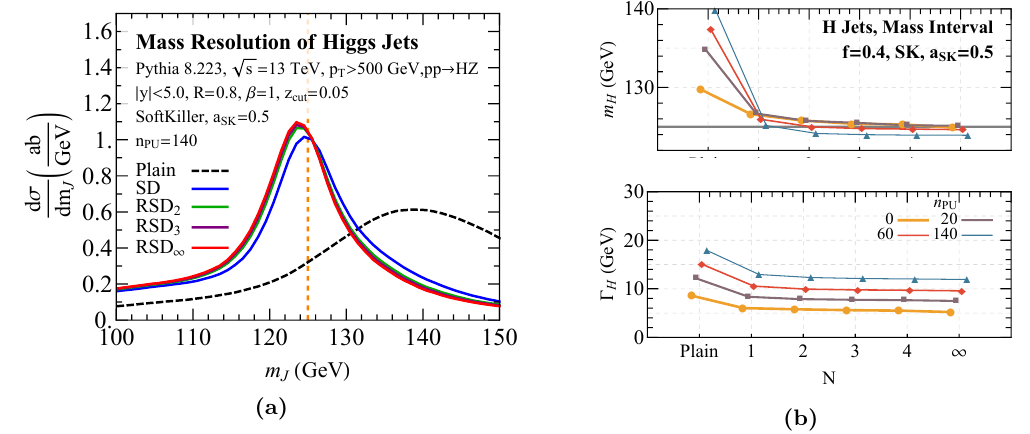
Figure 16. Same as (cid:12)gure 11 but for the H ( ! 4 q ) boson